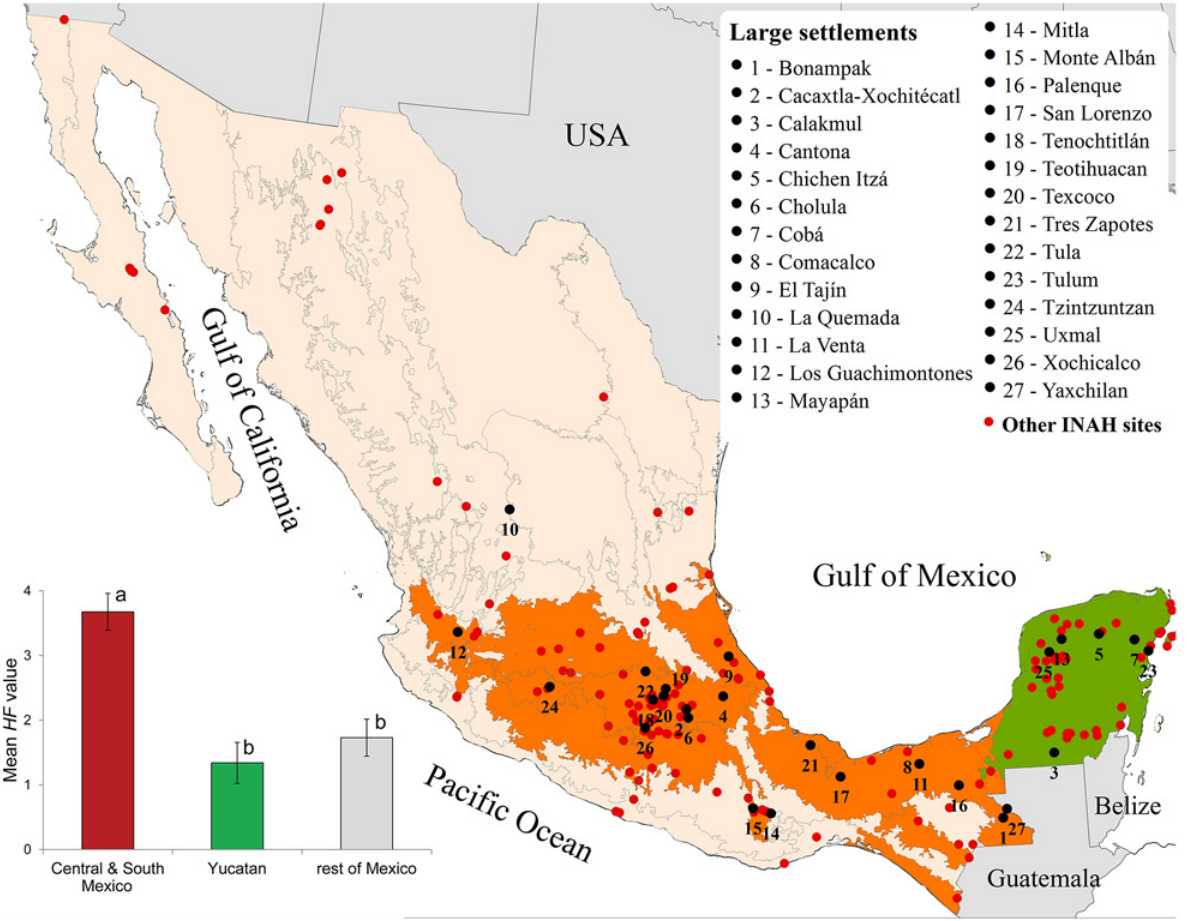
Fig 5. Distribution of the main pre-Hispanic settlements in Mexico. Map: Archaeological pre-Hispanic sites taken INAH (http://www.geoportal.inah.gob. mx) and major pre-Hispanic settlements taken from Kellog 2011, Sharer 1994, and Whitmore and Turner 2001 mapped over the ecoregions of Mexico (exact coordinates for each site located using GoogleEarth). The ecoregions that were most densely occupied at the time of the arrival of the first Europeans are marked in color. Inserted barchart: Mean Human Footprint value for (i) central and southern Mexico, (ii) the Yucatan peninsula, and (iii) the rest of Mexico. Different letters indicate values that differ significantly ( P < 0.05) from each